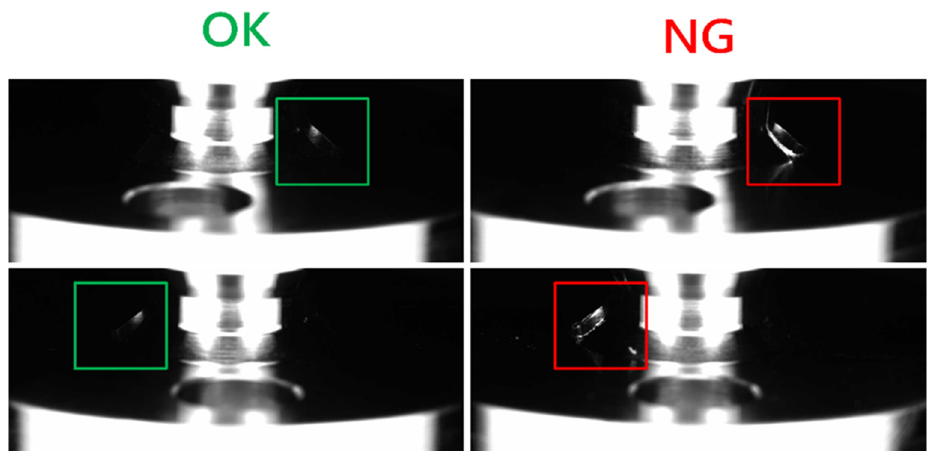
Figure 4. Photo of the OK items and the NG defect items.